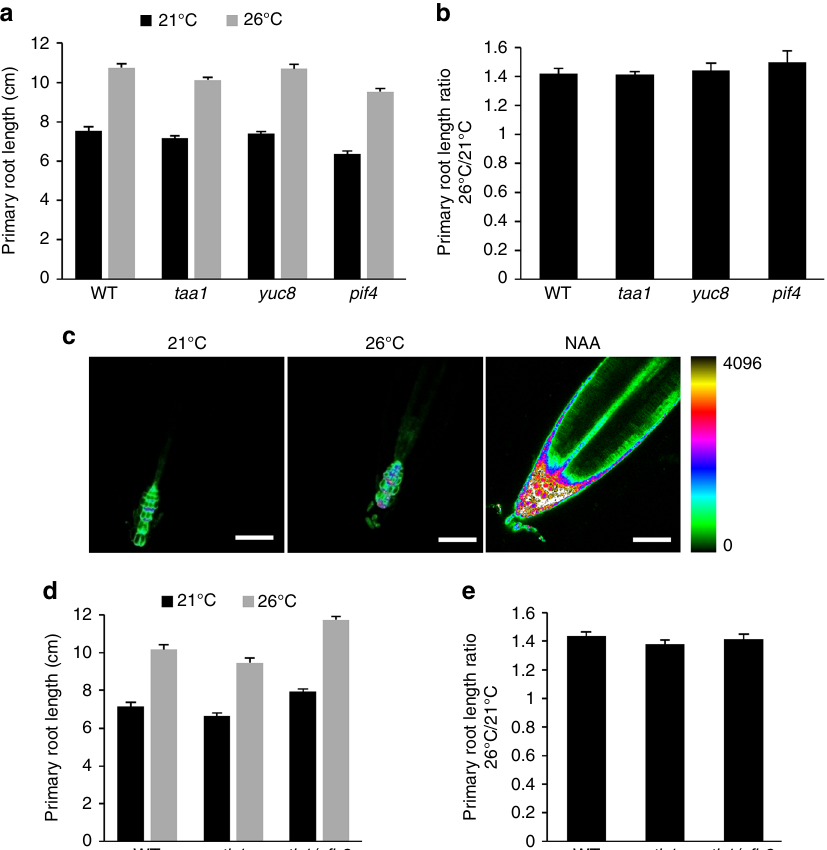
Fig. 2 Elevated ambient temperature responses do not involve auxin. a Primary root length of 15-day-old wild-type plants (WT) and mutants impaired in hypocotyl temperature responses (mean ± s.d., n = 25). The difference between the different genotypes for a given growth temperature is not statistically signi fi cant. b Ratio of primary root length from plants grown at 26/21 °C as in a (mean ± s.d., n = 3). The response to elevated growth temperature between the different genotypes is not statistically signi fi cant. c In fl uence of elevated growth temperature on auxin responses using the DR5::GFP synthetic auxin reporter. Exogenous application of 1 µ M NAA for 24 h is used as a control. Similar confocal detection settings were used to compare the three